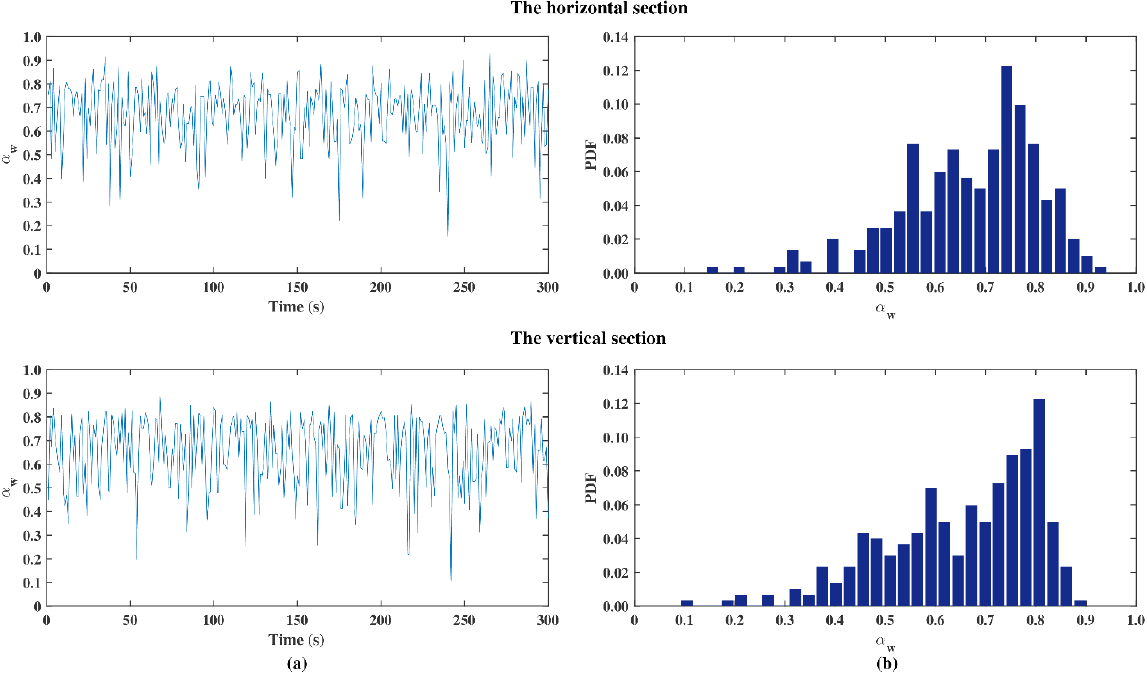
Figure 6. Typical evolution of the cross-sectional average water holdup α w and the probability density function (PDF) of the fluctuations in the volume fraction for oil – water – gas pipe flow ( Fr m = 0.368, u sg /u sm = 0.50, and 𝜀 𝑤 = 0.8 ). Plug flow in the ( a ) horizontal section and slug flow in the ( b ) vertical section.